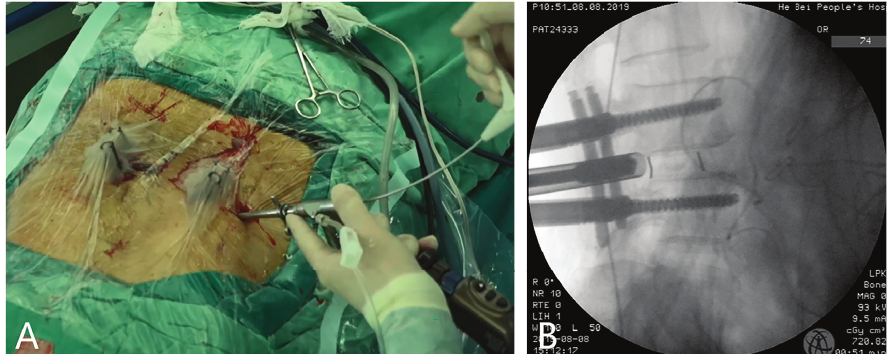
Figure 3: Percutaneous endoscopic lumbar interbody fusion following robot-assisted percutaneous pedicle screw implantation (a); intraoperative fluoroscopy image during the interbody fusion cage placement (b).